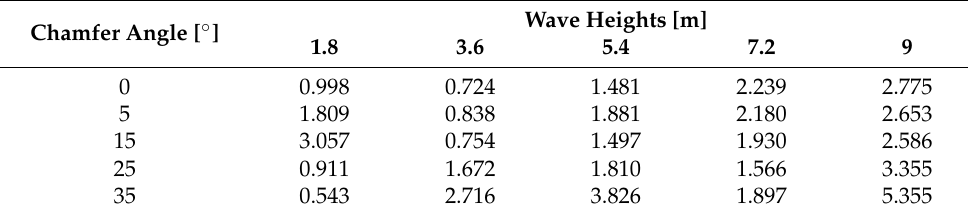
Table 5. Mean absolute deviation between the motion in the X direction in each case [m]. Chamfer Angle [ ◦ ]